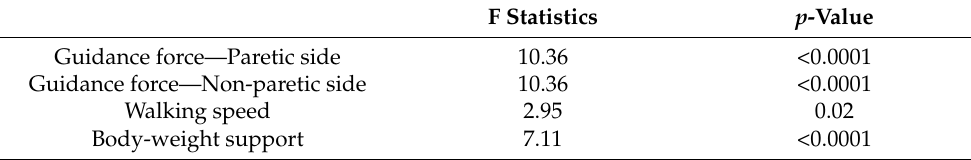
Table 5. The effect of time on the variables of adjustable RAGO parameters.